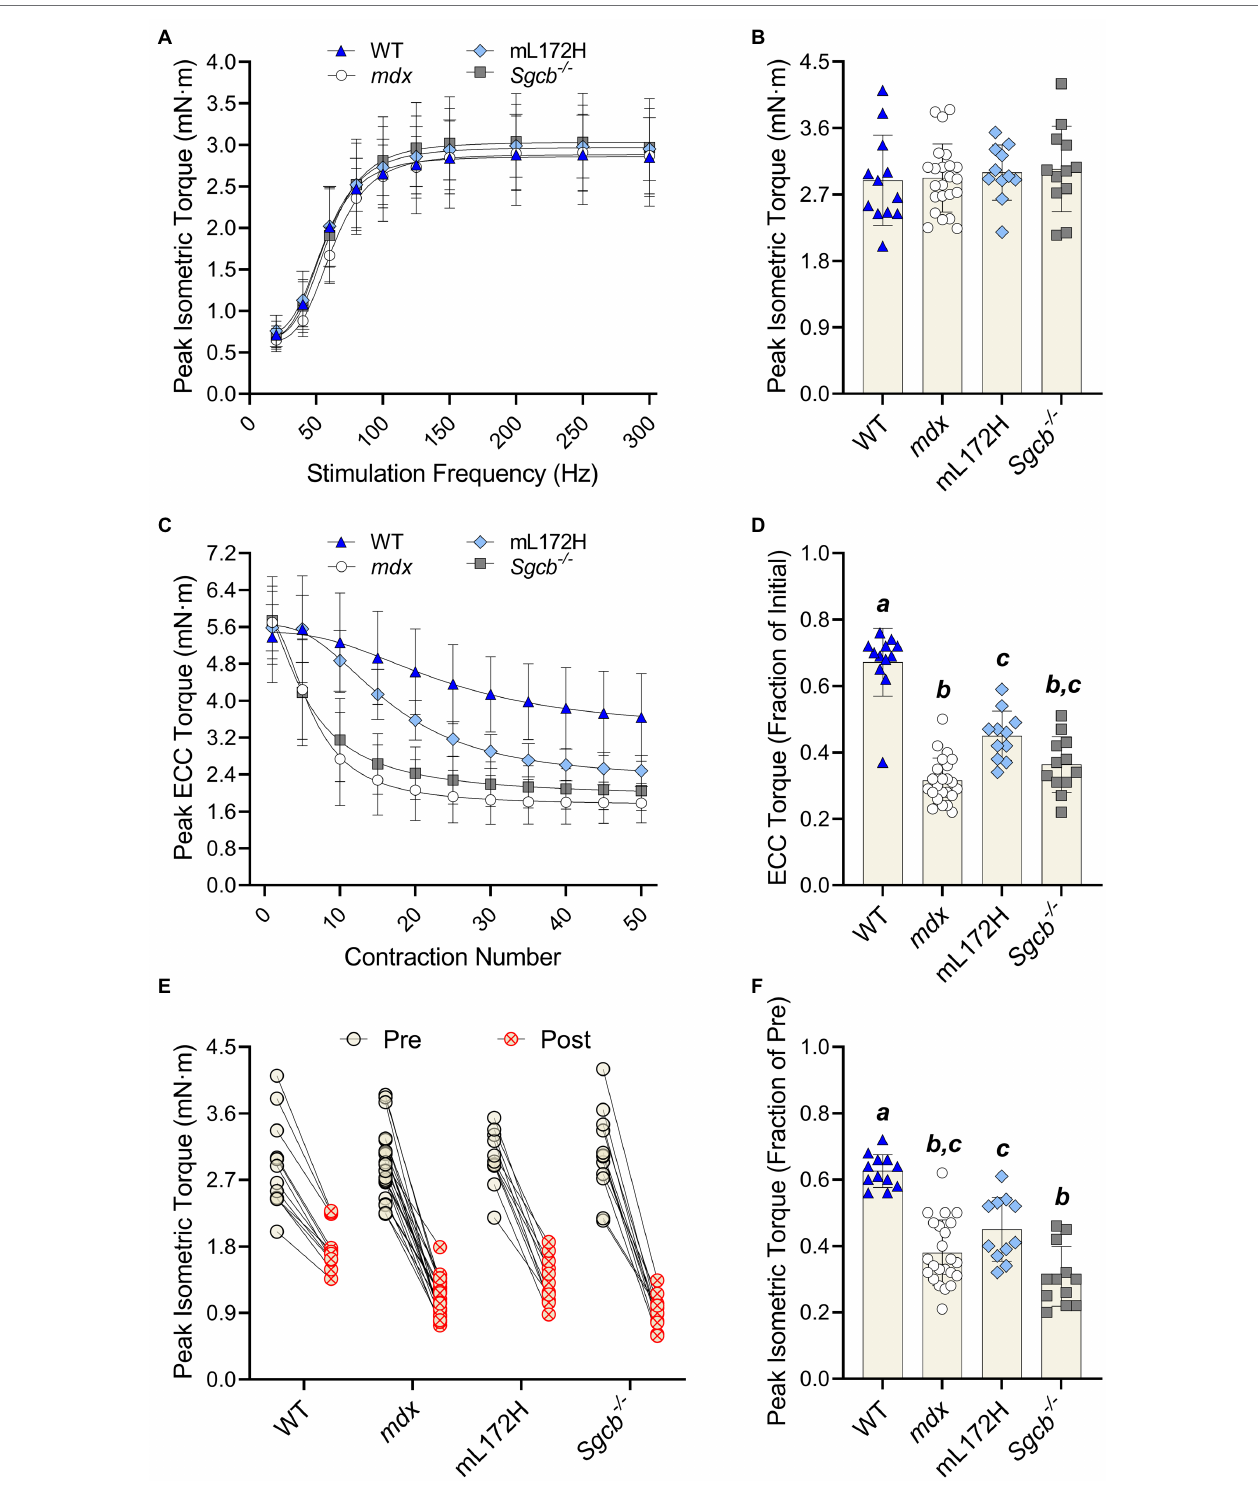
FIGURE 2 | Dystrophic mouse lines are hypertensive to ECC contraction-induced strength loss. (A) Pre-injury torque-frequency curves. Peak isometric torque was characterized as the highest tetanic contraction obtained during the torque-frequency protocol while (B) depicts pre-injury peak isometric torque. (C) Peak ECC torque over 50 maximal contractions. (D) ECC torque deficits expressed as a fractional change from the first to fiftieth contraction. (E) Peak isometric torque of each individual mouse pre- and post-ECC contractions; solid line between Pre and Post indicates same mouse. (F) Peak isometric torque expressed as a fractional change pre- to post-ECC contractions. Groups with the same letter are not significantly different from each. Significance was set at p < 0.05. Bars are mean ±